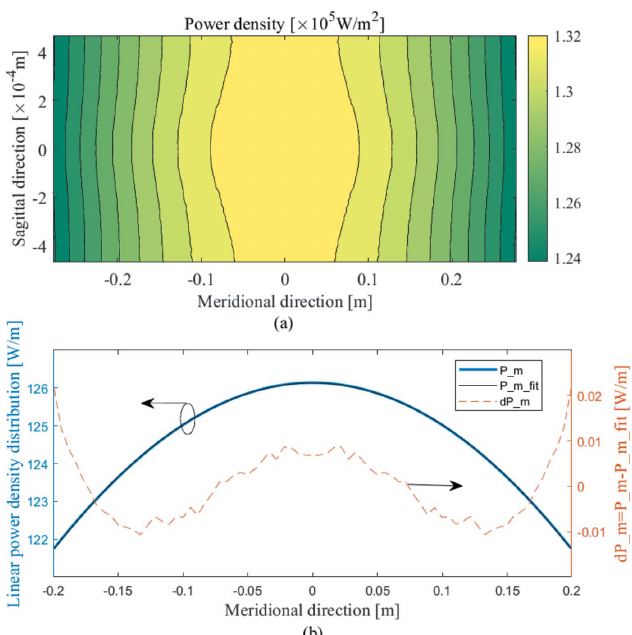
Figure 3 ( a ) Power density distribution for optimization, corresponding to P ð E Þ P ð E Þ = P C P ð E Þ . The normalized power density distribution p i i curvature of the power density distribution for optimization is equal to c p ( E ). Since all the given power density distribution curvatures are negative, the curvature of the power density distribution for optimization is negative. ( b ) Linear power density of the distribution in the meridian direction.